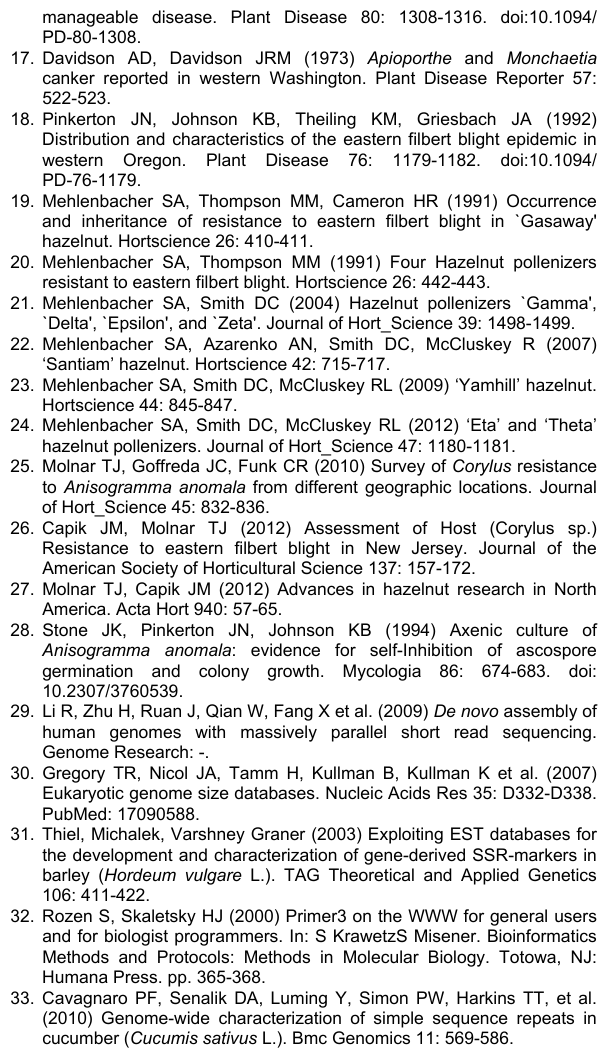
Table S2. Microsatellite motifs in A. anomala by motif type and number of